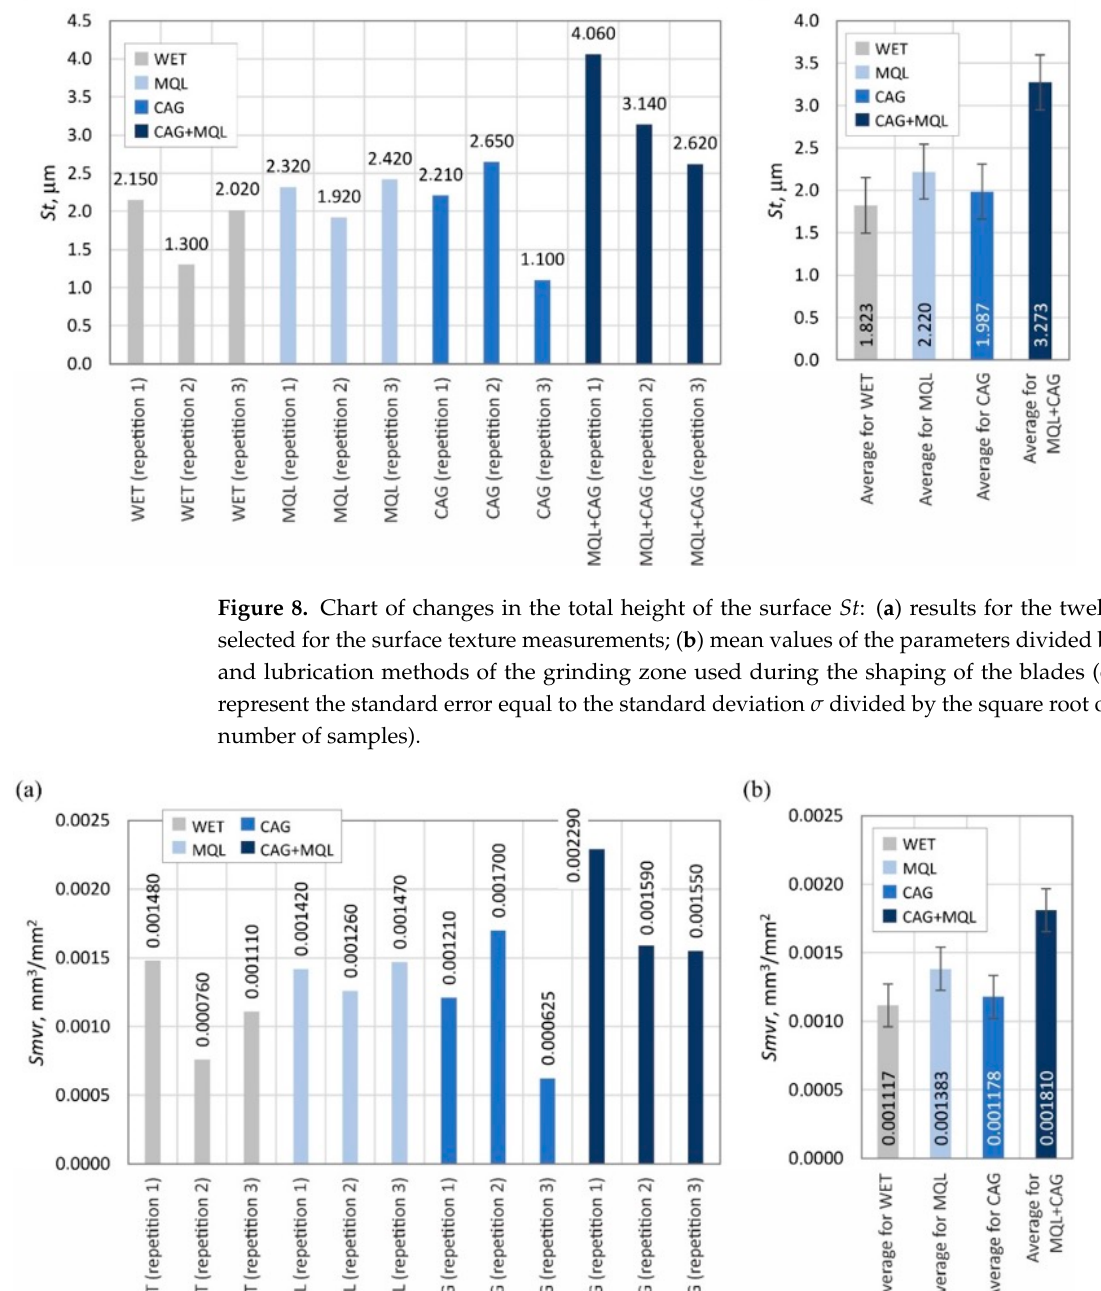
Figure 8. Chart of changes in the total height of the surface St : ( a ) results for the twelve blades selected for the surface texture measurements; ( b ) mean values of the parameters divided by cooling and lubrication methods of the grinding zone used during the shaping of the blades (error bars represent the standard error equal to the standard deviation σ divided by the square root of the total number of samples).